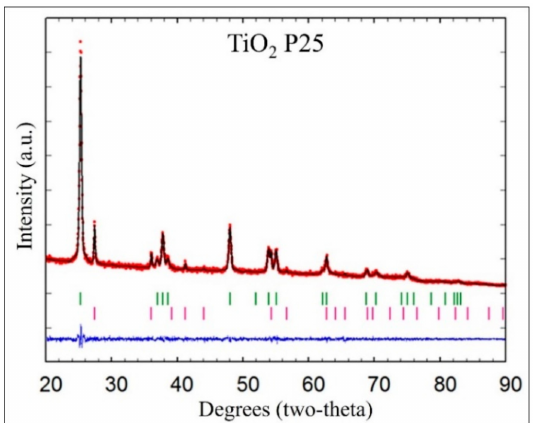
Figure 1. X-ray di ff raction (XRD) pattern for TiO 2 P25. The green vertical bars correspond to the TiO 2 anatase phase, JCPDS 00-021-1272; while the red vertical bars correspond to TiO 2 rutile, JCPDS 01-070-7347.